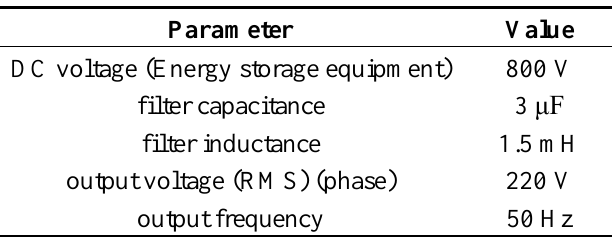
Table 1. Parameters of the